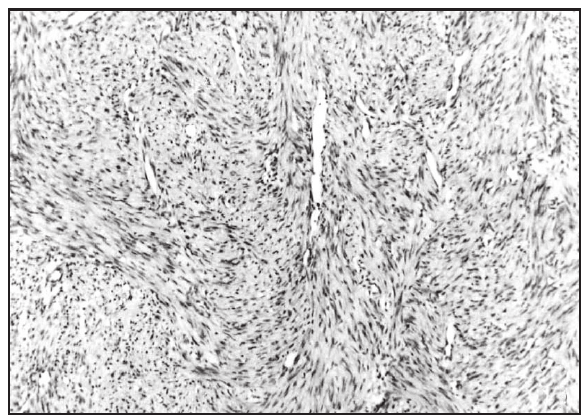
Figura 1 – Caso 1/H.E. Feixes de células fusiformes entrelaçados aleatoriamente em um estroma predominantemente celular e vascularizado